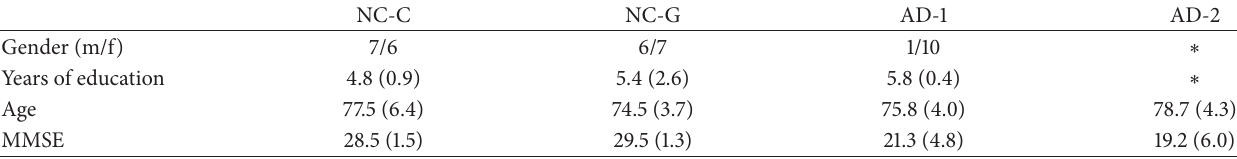
Table 1: Background information about the participants in the study (means and standard deviation, in